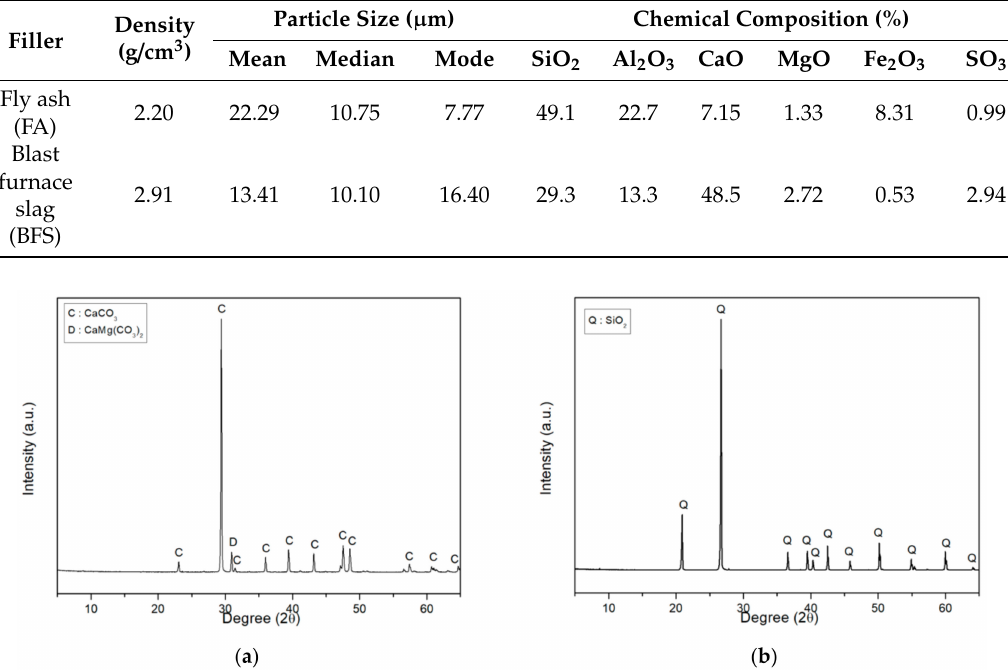
Table 5. Physical and chemical properties of amorphous fillers.